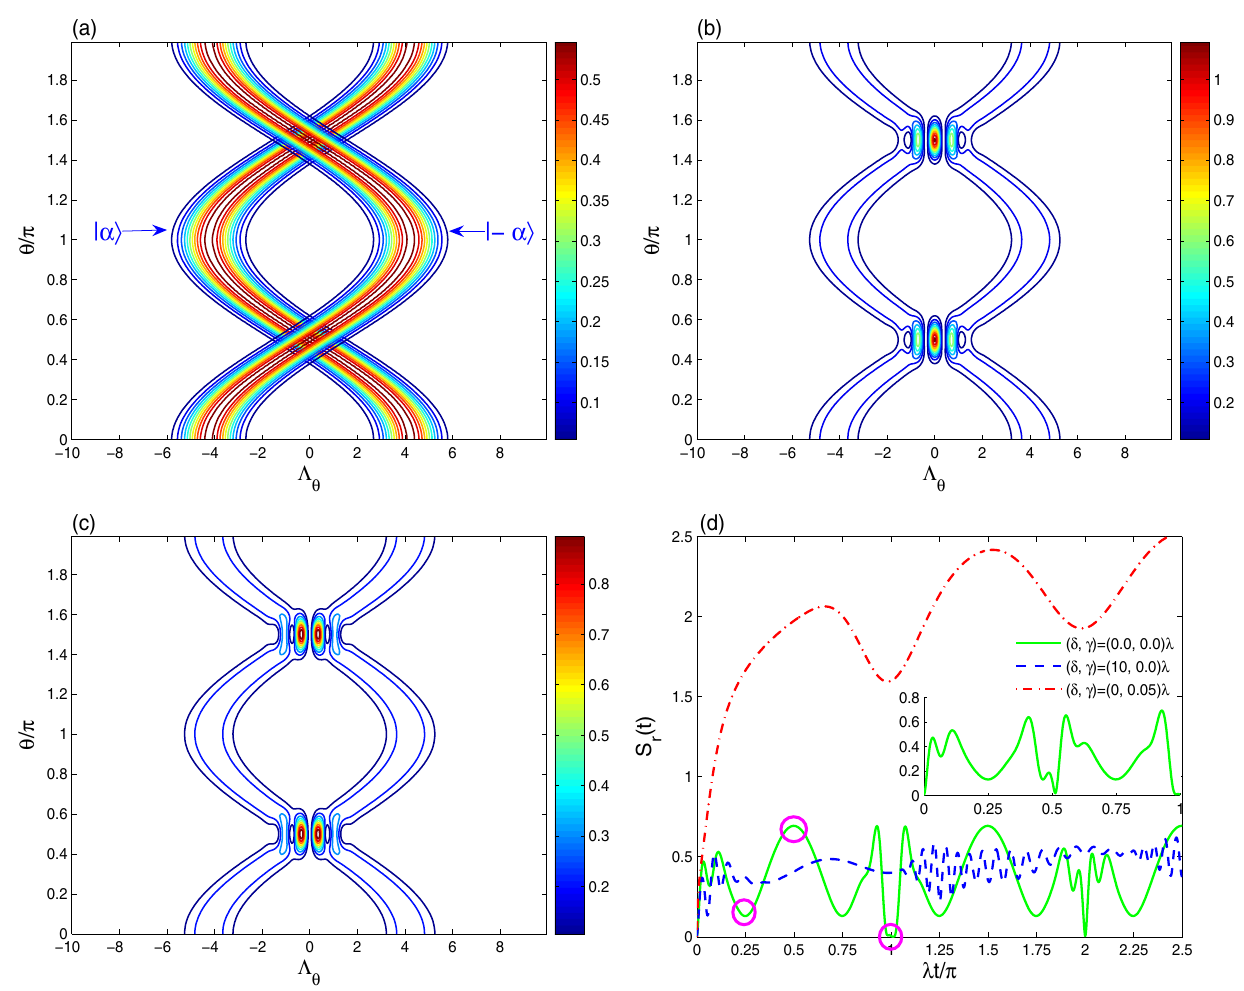
Figure 1. Optical tomography contour of the coherent state is illustrated in ( a ), the even coherent state in ( b ), 2 = 9 and the odd coherent state in ( c ) for | α | . In ( d ), the dynamics of the resonator field entropy under the decoherence and detuning effects is plotted for the coherent state, and the even coherent state in the π (the resonator state is in a pure This result is confirmed for the optical CS-tomography displayed at (cid:31) t = state, see Fig. 1d). The generated resonator state presents optical tomography with cosine-curve function which α is similar to of the coherent state , see Fig. 1a. This means that the generated pure resonator state is the | − � α coherent state . | − � π , α Figure 2d shows the dependence of the optical tomography of the coherent state , generated at (cid:31) t = | � 10 (cid:31) . The amplitudes and the intensity of the optical tomography are enhanced due to the with the detuning δ = increase of the qubit-resonator detuning. 0.05 (cid:31) on the generated optical CS-tomography at the Figure 3, displays the intrinsic decoherence effect γ = 1 π and (cid:31) t π of Fig. 2b,c. The intrinsic decoherence effect leads to: (1) the amplitudes and different times (cid:31) t 2 = = 1 π and (cid:31) t π , the the contour intensity of the CS-optical tomography are reduced at different times. At (cid:31) t 2 = = sizes of the distribution shape change due to the intrinsic decoherence effect. In the case of resonance, we observe that optical tomography for a periodic regular dynamics which could be considered as an indicator of the degree of the pureness of the field-resonator states. The regularity of the generated optical tomography disappears as the qubit- resonator detuning increases, i.e., the probability genera- tion another pure coherent resonator states, due to the qubit-resonator interactions is very low. The intrinsic decoherence increases the mixedness of the generated filed-resonator states, leading the interference optical tomography regions to vanish. In the Fig. 4, for the qubit-resonator interaction, the dynamics of the optical tomography contour of the initial 1 1 π , (cid:31) t π and (cid:31) t π is plotted. For the resonant case δ 0 and even coherent state at different times (cid:31) t 4 2 = = = = (cid:31) t 1 π , the contour plot illustrates that the optical tomography has more picks (which appear at high intensity) 4 = and more intersected symmetric as well as regular path. The amplitudes and the contour intensity of the generated 1 π (see optical ECS-tomography are smaller than those of the initial even coherent state, see Fig. 1b. At (cid:31) t 2 = Fig. 4b), the resonator reduced matrix presents a new shape for the the optical ECS-tomography with two regular sine-curve paths. It is similar to the initial even coherent state of Fig. 1b as it is expected from the dynamics of the